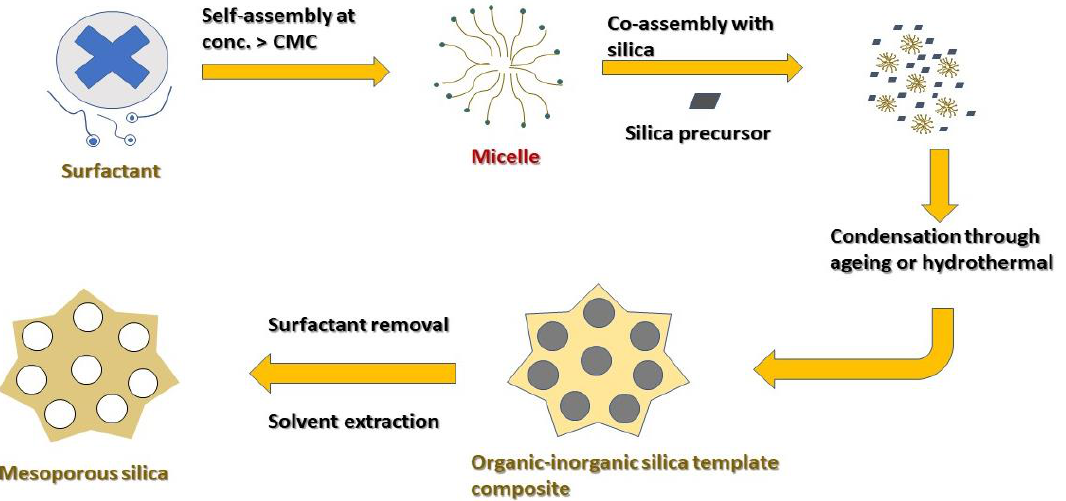
Figure 1. General synthesis of mesoporous silica nanoparticles. Modified from [9], published by MDPI, 2020 .